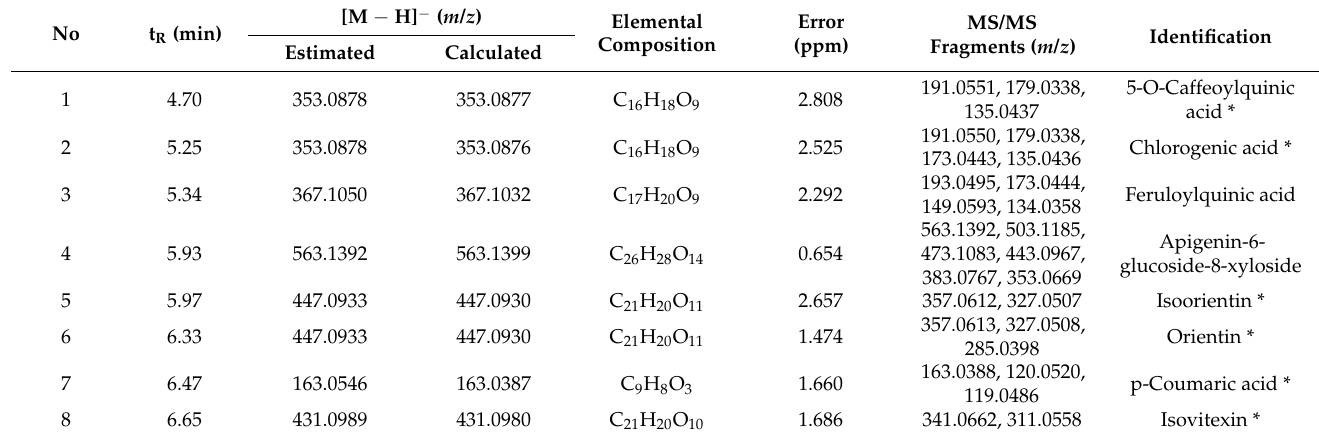
* compared with the retention time and MS spectral data of authentic standards.